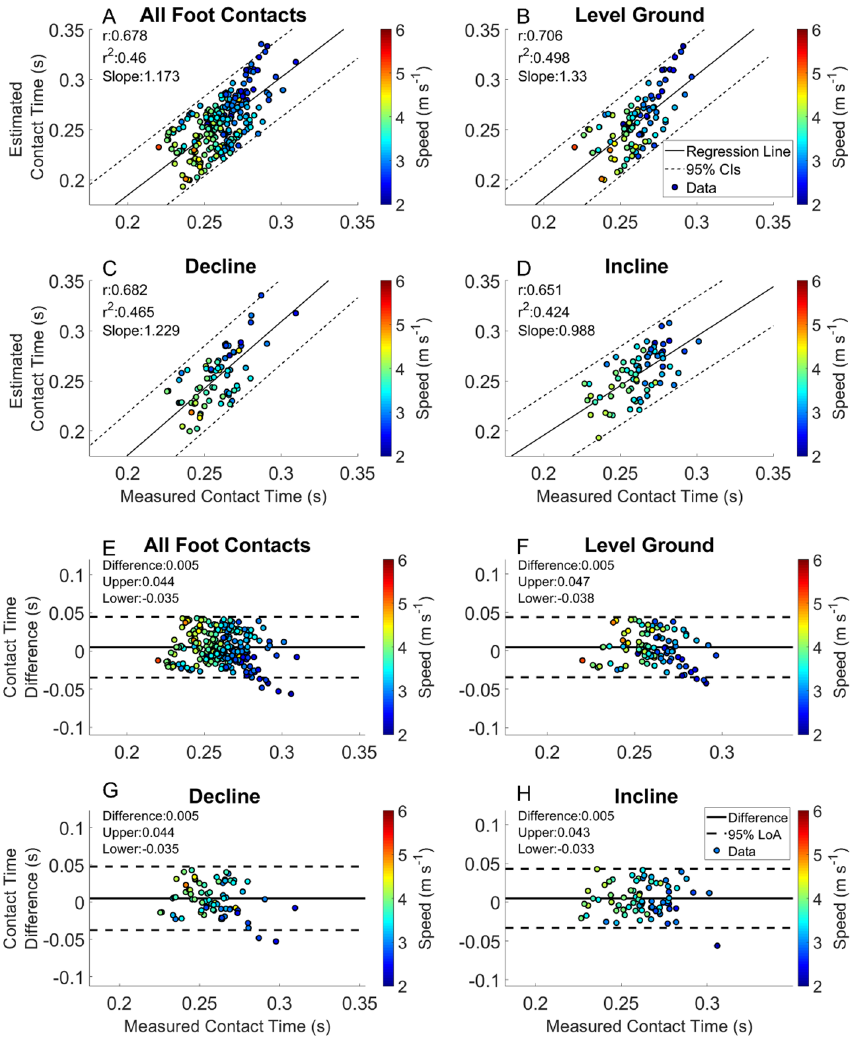
Figure 2. Estimated contact time from foot mounted IMUs. Linear regression and Bland–Altman plots are presented for all foot contacts ( A and E ), followed by level ground ( B and F ), decline ( C and G ) and incline foot contacts ( D and H ). Pearson Correlation Coefficients, and the slope of the regression line are presented in panels ( A )–( D ). The Bland–Altman plots present differences between the estimated and measured contact time. The average difference and the 95% LoA are shown in panels ( E )–( H ).